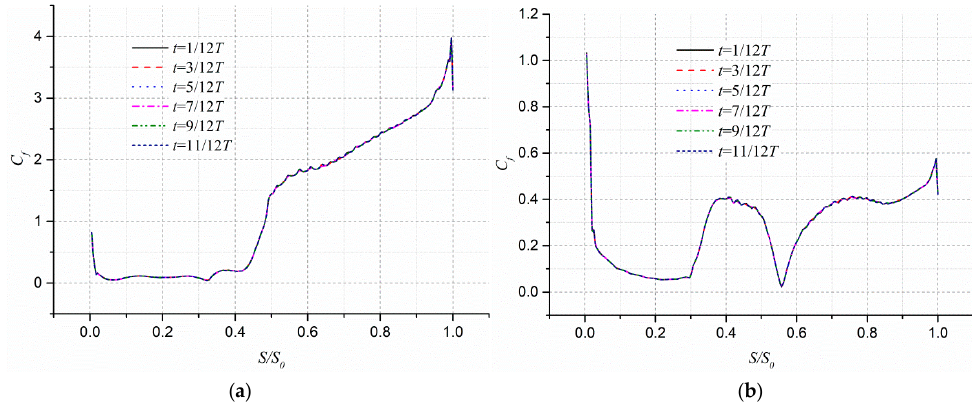
Figure 7. Distribution of the pressure coefficient on the blade surface for the Z / b 2 = 0.5 cross section: ( a ) pressure surface and ( b ) suction surface.